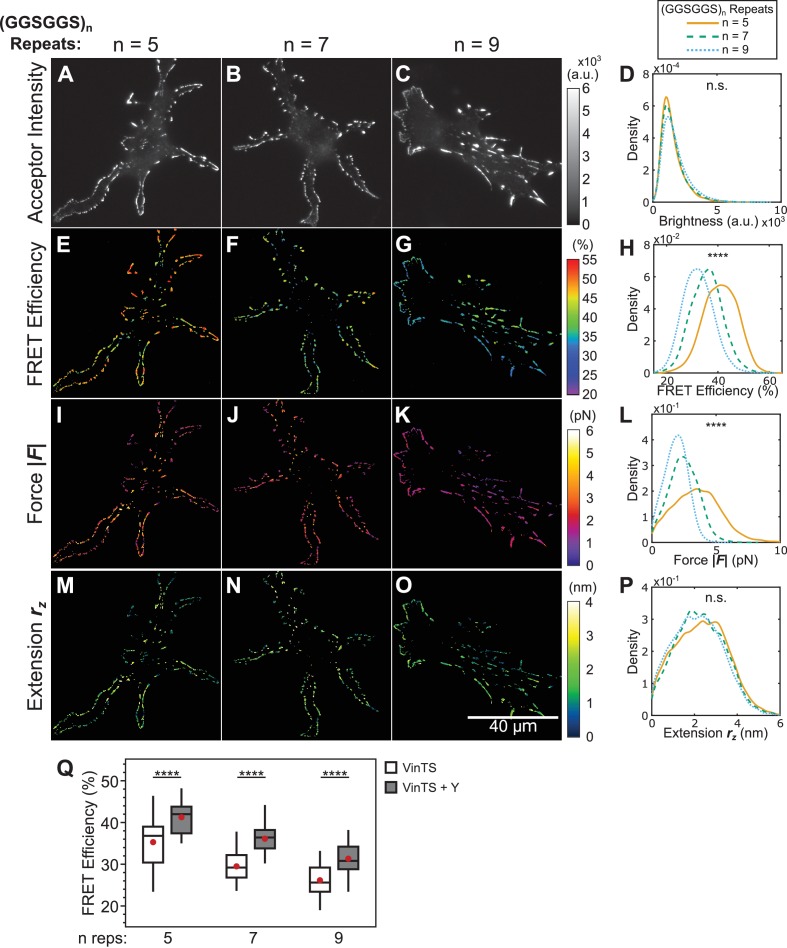
Effect of Y-27632 treatment on vinculin extension-control.(A-C) Representative images of the localization of a trio of vinculin tension sensors to FAs formed in cells treated with Y-27632. (D) Normalized histograms of acceptor intensities at FAs are indistinguishable between the three sensors. (E-G) Representative images of masked FRET efficiency and (H) normalized histograms of average FA FRET reported by each sensor. (I-K) Representative images of forces and (L) normalized histograms of average vinculin force in FAs reported by each sensor. (M-O) Representative images of extension and (P) normalized histograms of average vinculin extension in FAs reported by each sensor. Note that ~10% of FAs exhibited negative forces/extensions and were excluded from the analysis in panels (L and P). All normalized histograms depict data from individual FAs; n = 50, 40, 42 cells and n = 8623, 6944, 7839 FAs for (GGSGGS)5,7,9 extensible domains, respectively; data pooled from three independent experiments; ****p<0.0001, n.s. not significant (p≥0.05), ANOVA. (Q) Quantification of cell-average FRET efficiency in control compared to Y-27632-treated VinTS-expressing cells; data represents ≥40 cells per condition, pooled from three independent experiments; red filled circle denotes sample mean; ****p<0.0001, Student’s t-test, two-tailed, assuming unequal variances. See Supplementary file 4 for exact p-values and multiple comparisons test details.